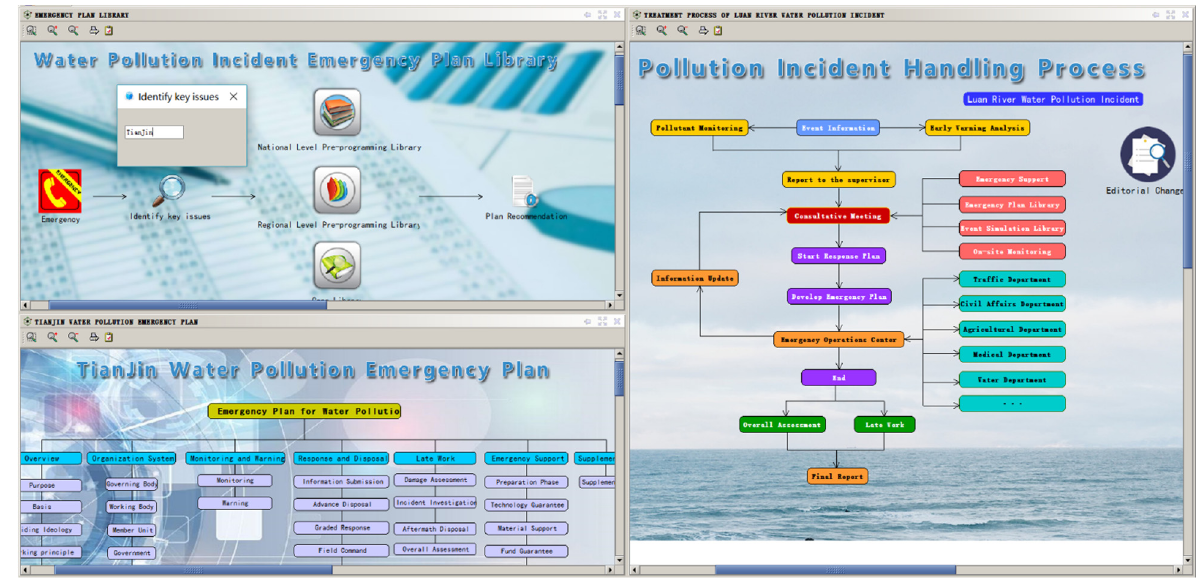
Figure 11. Pre-plan query matching results.